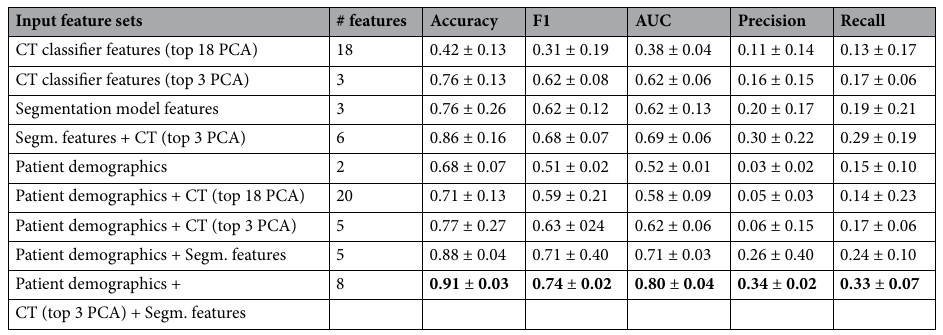
Table 3. CC-CCII Prognosis Results with Leave One Out cross-validation. Significance values are in bold.